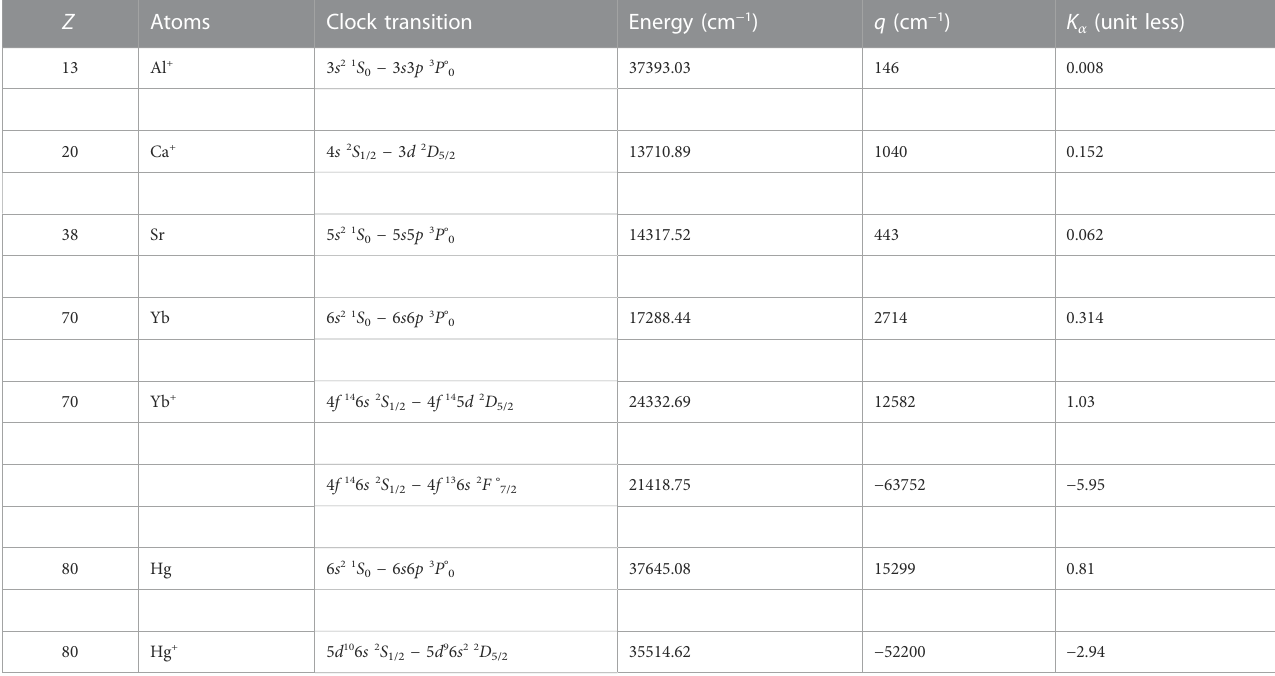
TABLE 1A summary of the sensitivity coef fi cients, q and K α ,of the clock transition frequency tovariationof α ,withde fi nition givenin text andthe data source istaken from Ref. [11]. Z Atoms Clock